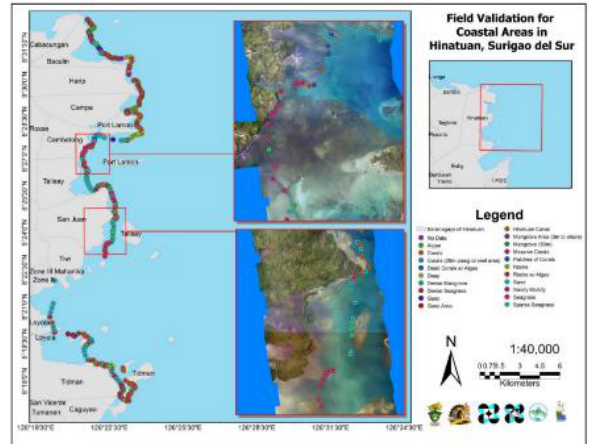
Figure 12. Sample map of actual validated points in selected coastal areas in Hinatuan, Surigao Del Sur